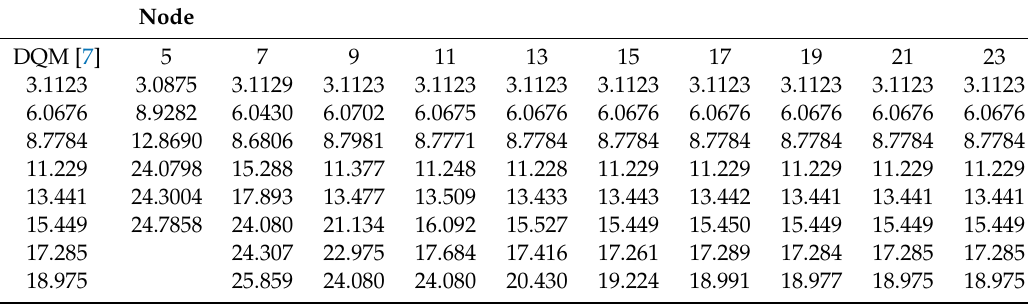
Table 1. Convergence analysis of the size-independent Timoshenko beam model.